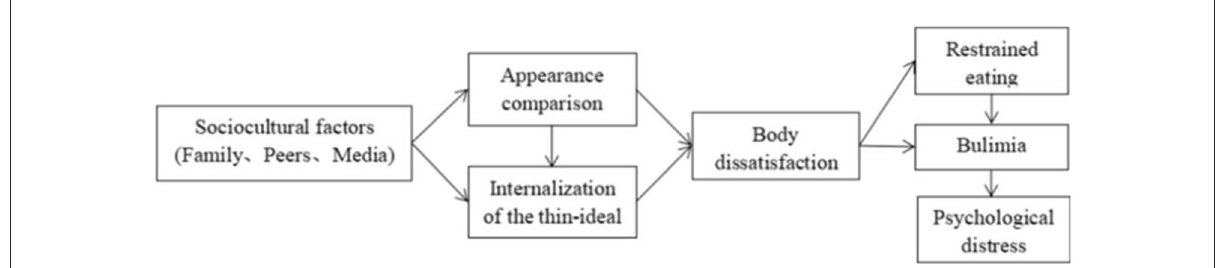
FIGURE1 The Tripartite Influence Model of body image based on Thompson et al. (1999).